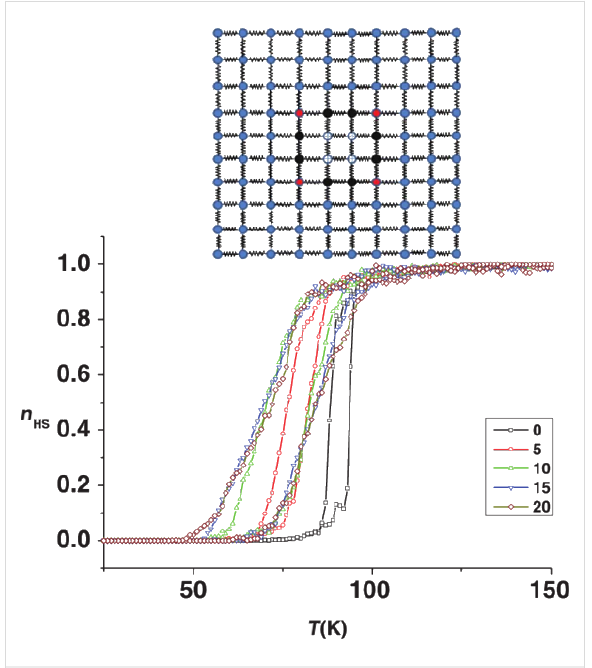
Figure 9: Thermal SCO curves for different thicknesses of an inactive HS shell, calculated with a compressible Ising-like model with harmonic potential. Top panel: core–shell system with an SCO active core and an inactive HS shell. Adapted with permission from [40], copyright 2013 American Physical